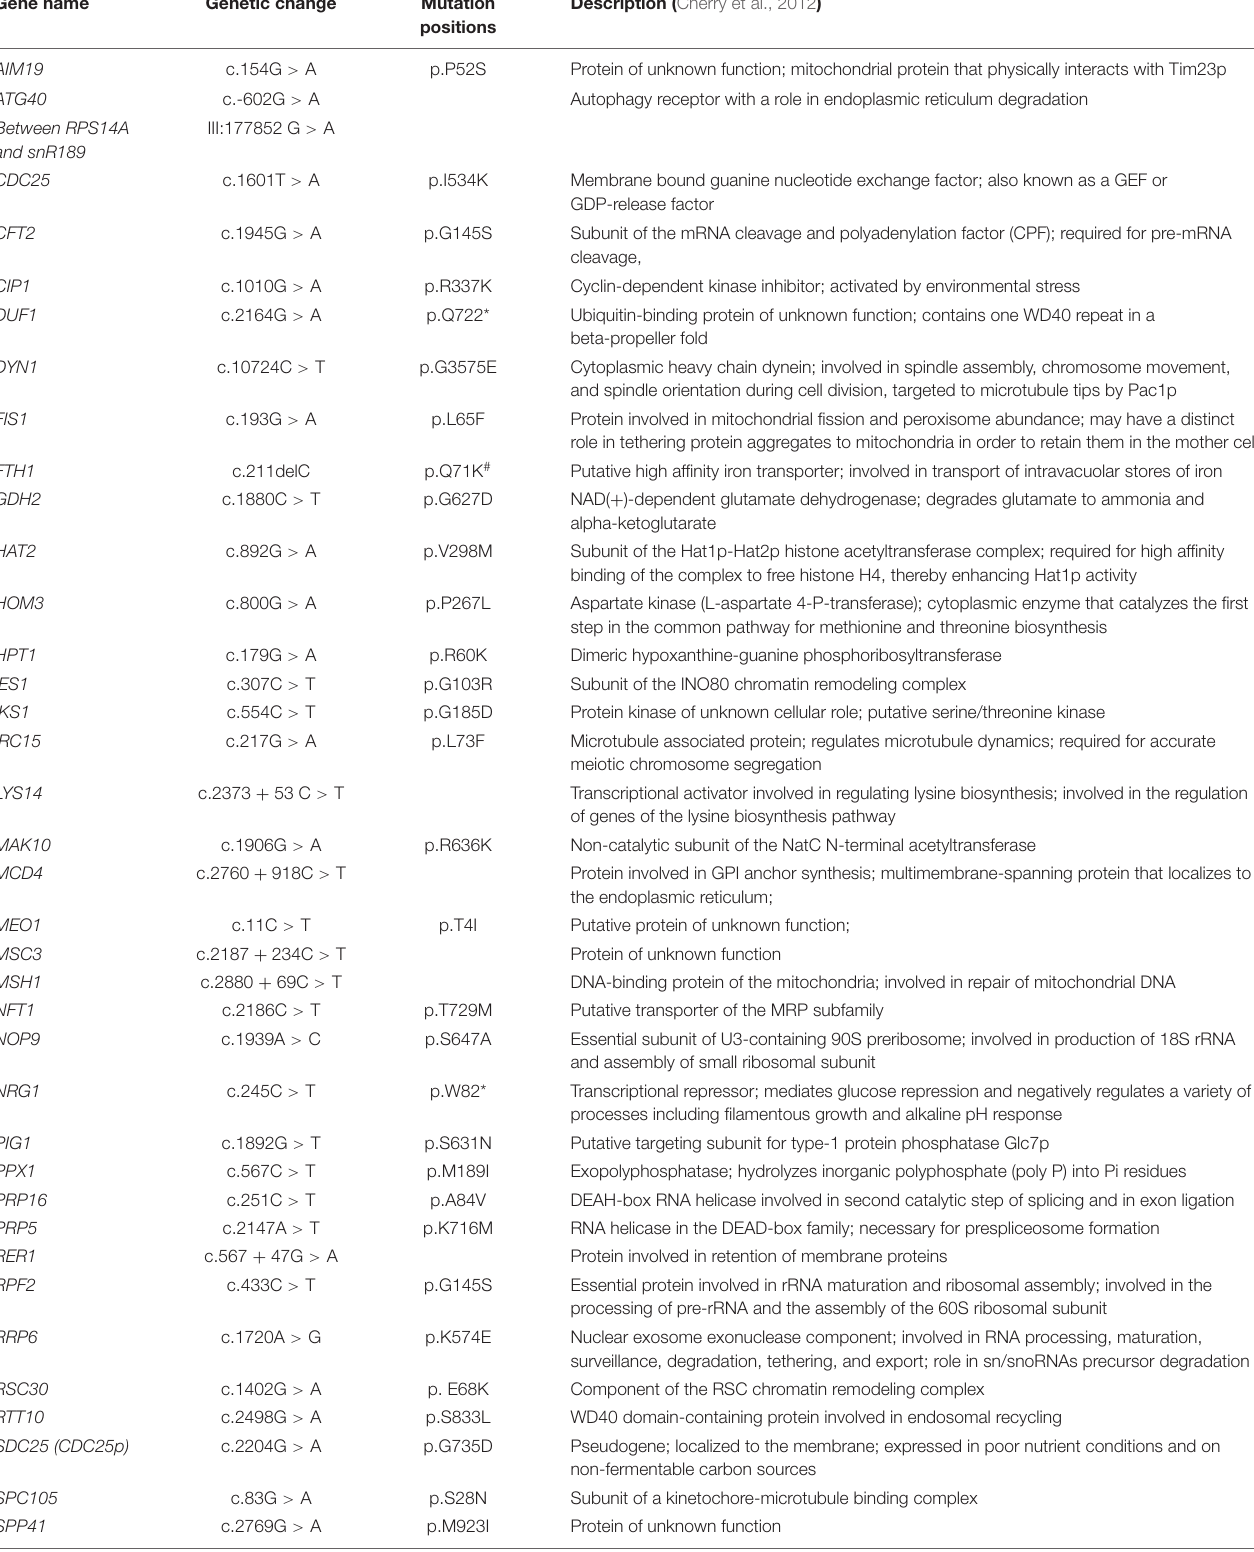
TABLE 4 | Mutation positions and types in the genome of the oxidative stress-resistant evolved strain